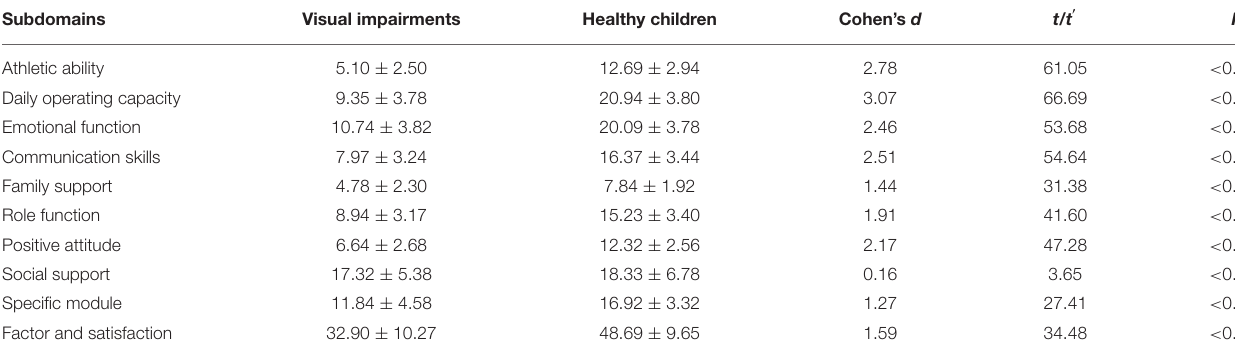
TABLE 6 | Score comparisons between healthy children and visually impaired children (X